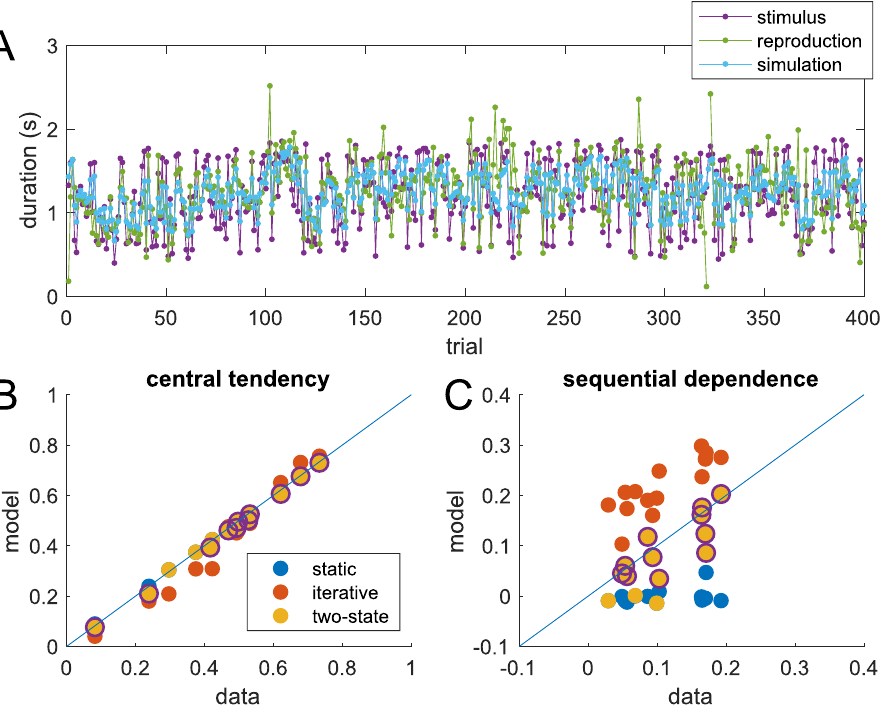
Figure 4. (A) Time course of stimulus (magenta) and reproduction (green) from one participant (same data as in Fig. 2C,D) together with best fit of the two-state model (light blue). The model fitting minimized the least-squares distance between reproduction (green) and simulation (light blue). The input to the model was the trial-by-trial stimulus time course (magenta). The few outliers (e.g., around trial 105 or 320) were not removed for model fitting. ( B,C ) Comparison of experimental data (x-axis) and model simulation (y-axis) for central tendency ( B ) and absolute sequential dependence ( C ) for all three models and all participants. Each dot represents one participant. The central tendency is captured correctly by all three models (values close to the diagonal), whereas the model values for sequential dependence are too small for the static model (blue dots, close to zero), and too large for the simple iterative model (red dots). Values for the two-state model lie closer to the diagonal in most cases. Cases for which the two-state model was the best model according to cross- validation are highlighted by circles: for 8 of 14 participants, the two-state model was superior, while in the remaining 6 cases the static model was sufficient to explain the